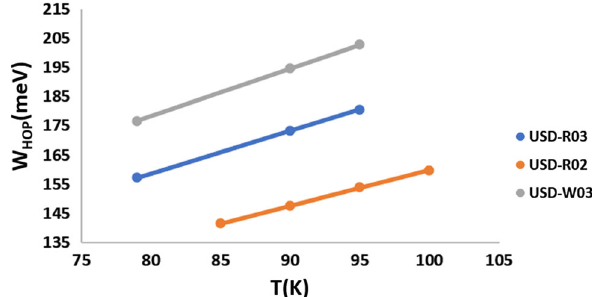
Fig. 7 Shown is the variation of hopping energy with temperature for three different detectors